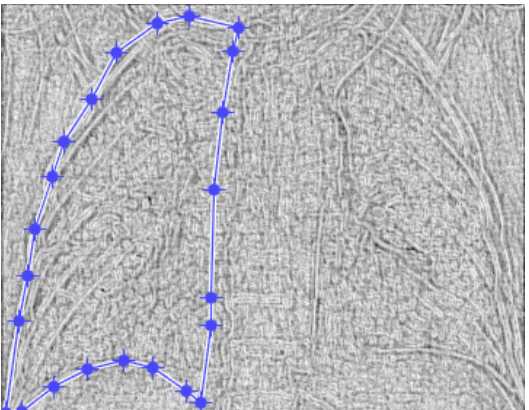
Figure 19. De fi ning the mask for the left lung of the fourth patient.